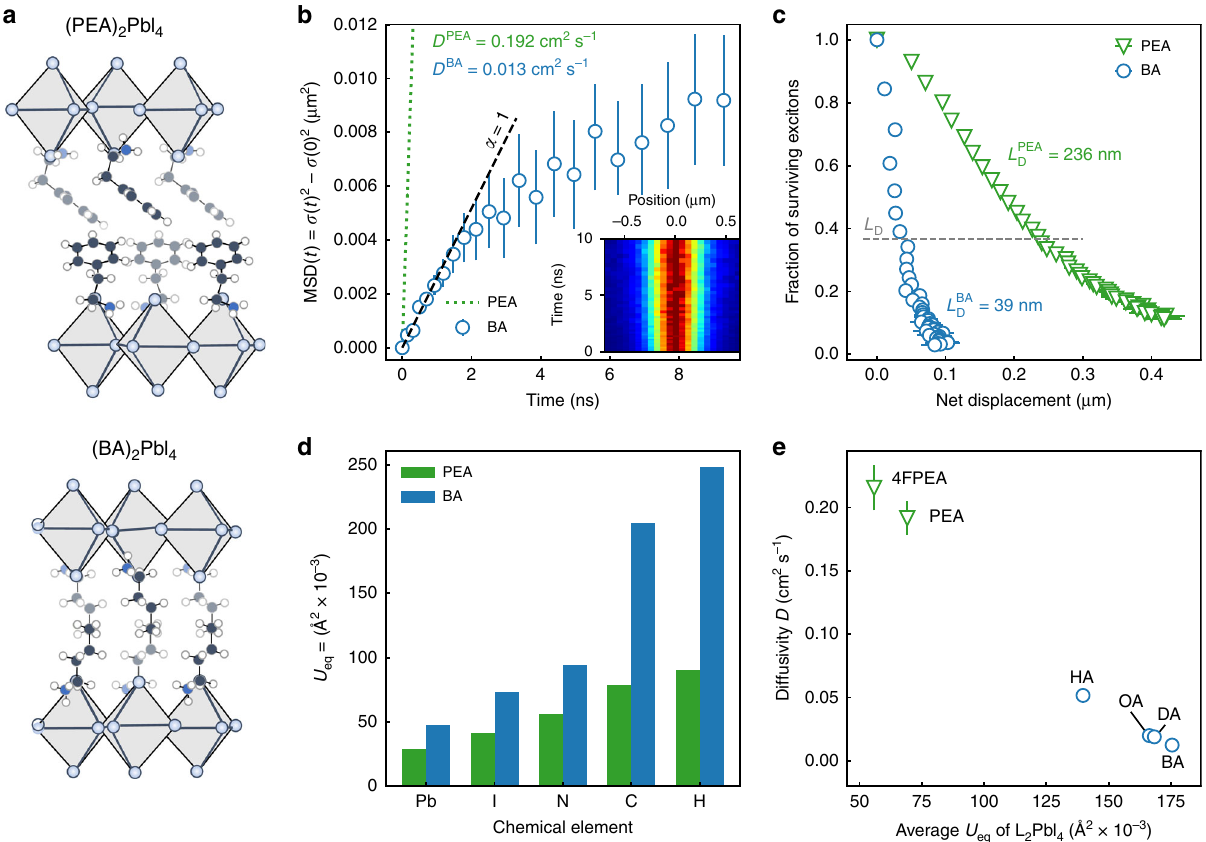
Fig. 3 Exciton diffusion in (PEA) 2 PbI 4 and (BA) 2 PbI 4 . a (PEA) 2 PbI 4 and (BA) 2 PbI 4 crystal structure along the a crystal axis 53,54 . b Mean-square- displacement of exciton population over time for (PEA) 2 PbI 4 (dotted line) and (BA) 2 PbI 4 (circles). Inset shows the normalized fl uorescence emission intensity I( x , t ) for (BA) 2 PbI 4 . Reported errors represent the uncertainty in the fi tting procedure for σ ( t ) 2 . c Fractions of surviving excitons (extracted from ffiffiffiffiffiffiffiffiffiffiffiffiffiffiffiffi p lifetime data in Supplementary Fig. 7) as a function of net spatial displacement of excitons for (PEA) 2 PbI 4 (triangles) and (BA) 2 PbI 4 (circles). MSD ð t Þ Reported errors represent the uncertainty in the fi tting procedure for σ ( t ) 2 . d Average atomic displacement U eq of the chemical elements in (PEA) 2 PbI 4 and (BA) 2 PbI 4 . Data was extracted from previously published single crystal X-ray diffraction data 53,54 . e Diffusivity D as a function of average atomic displacement U eq for different organic spacers: 4- fl uoro-phenethylammonium (4FPEA) 65 phenethylammonium (PEA) 53 , hexylammonium (HA) 54 , octylammonium (OA) 66 , decylammonium (DA) 66 , Butylammonium (BA) 54 . Reported errors represent the standard deviation of the average diffusivity D